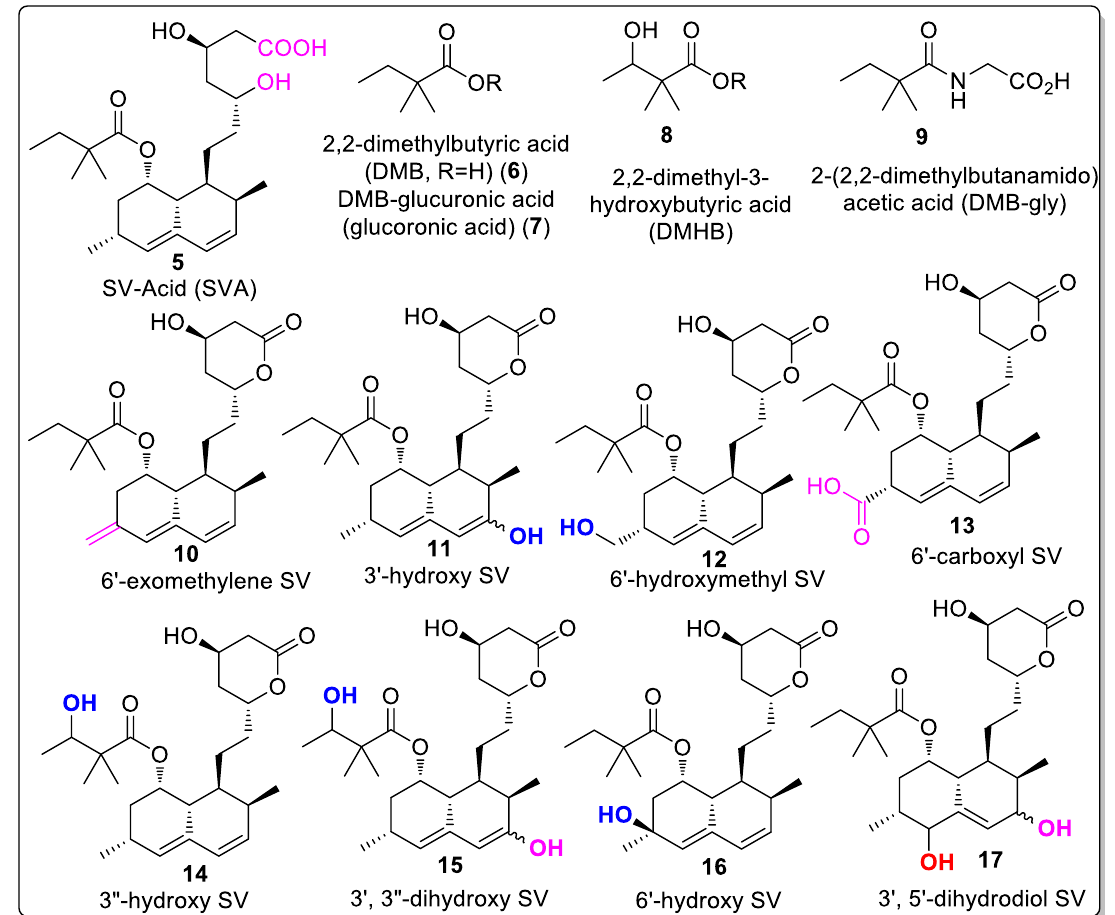
Figure 2. Reported structures of metabolites of SV (The colors indicate the possible metabolic site).